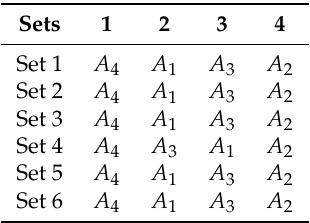
Table 17. Ranking order under the variation of criteria